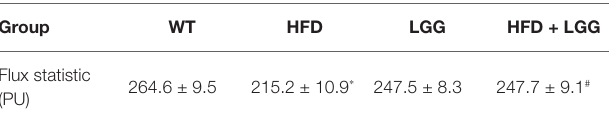
TABLE 3 | Gingival blood flow measurements presented as mean ±